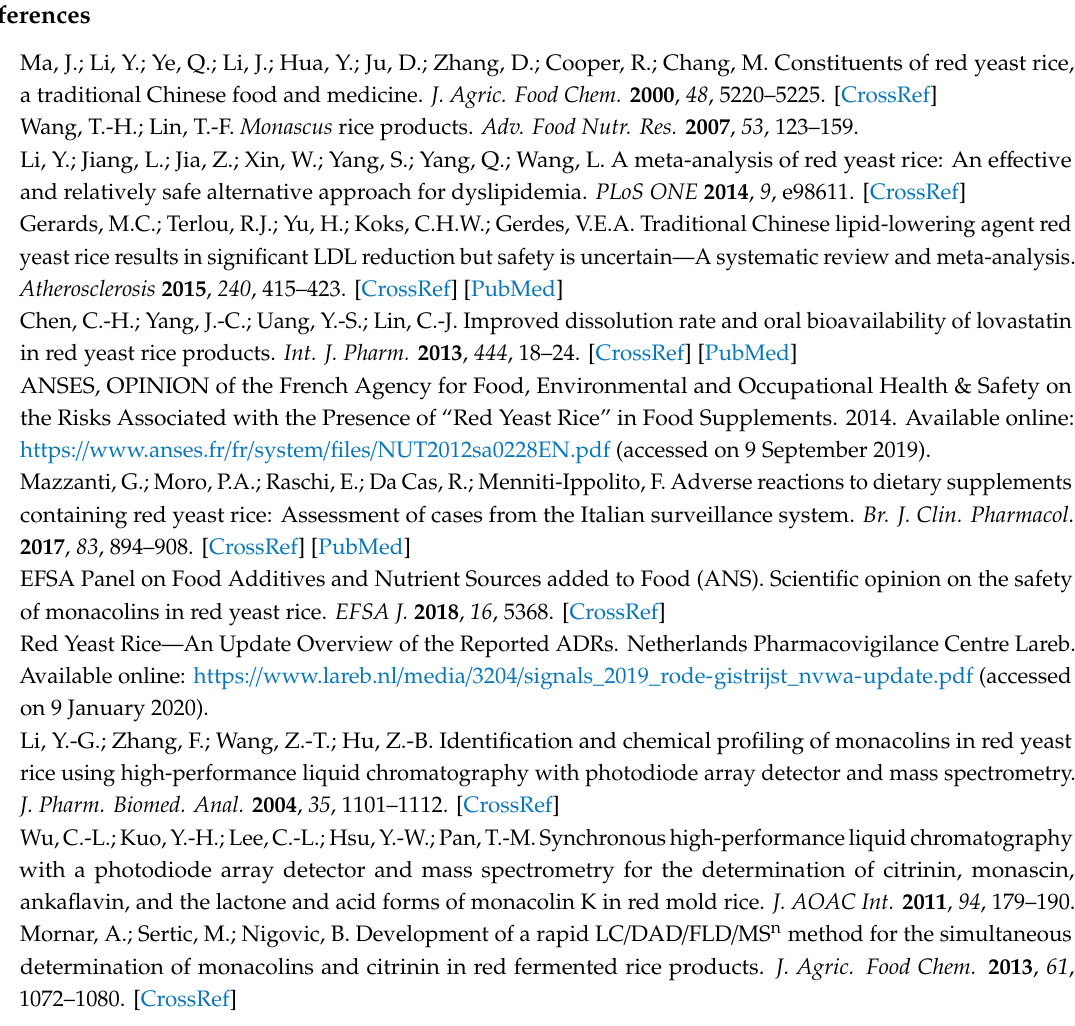
Supplementary Materials: The following are available online, Table S1: 1 H and 13 C-NMR data (solvent: CD 3 CN:D 2 O 80:20) of monacolin K in lactone (MK) and hydroxyl acid (MKA) forms, compactin and dihydromonacolin K. Table S2: 1 H-NMR quantitative determination of monacolins in RYR dietary supplements. Table S3: Comparison of monacolin amounts measured in RYR dietary supplements by 1 H-NMR and UHPLC. Figure S1: 1 H-NMR spectra (CD 3 CN:D 2 O (80:20)) of all the dietary supplements analyzed in the present study. Upper part: entire spectrum, lower part: enlarged downfield region (4–9 ppm). Figure S2: UHPLC chromatograms with UV detection at 238 nm (A) and full scan MS profile in positive ESI mode (B) of 9 RYR dietary